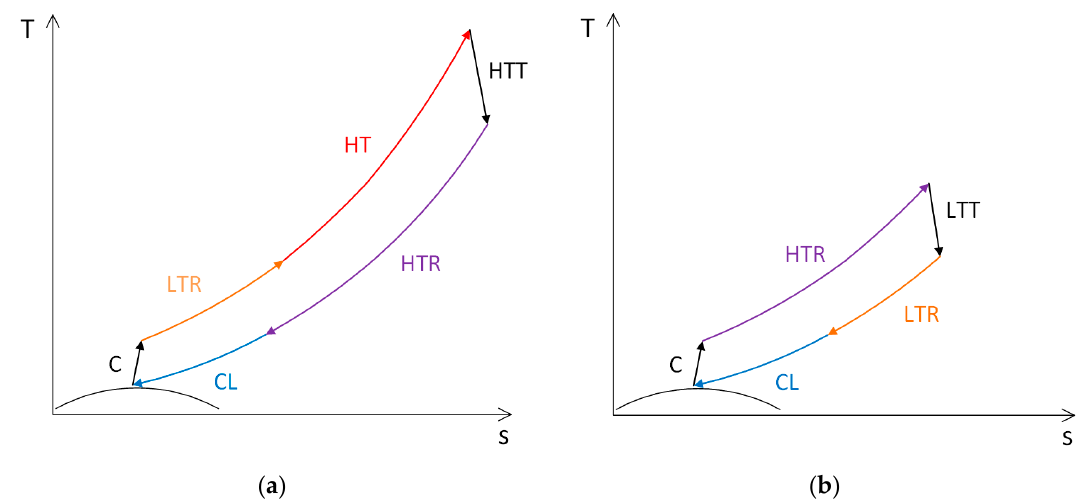
Figure 6. Decomposition of the dual recuperated s-CO 2 cycle into two elementary thermodynamic cycles: ( a ) First elementary cycle; ( b ) Second elementary cycle.